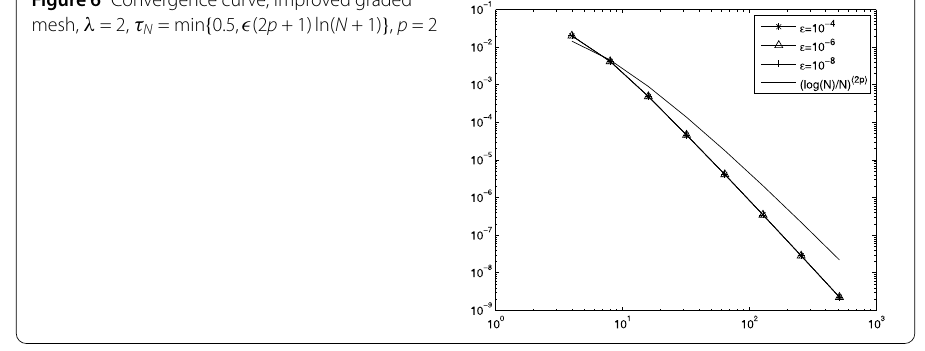
Figure 7 Convergence curve, improved graded mesh, λ = 2, τ (cid:2) = min { 0.5,– (cid:2) ( p + 1)ln (cid:2) } , p =